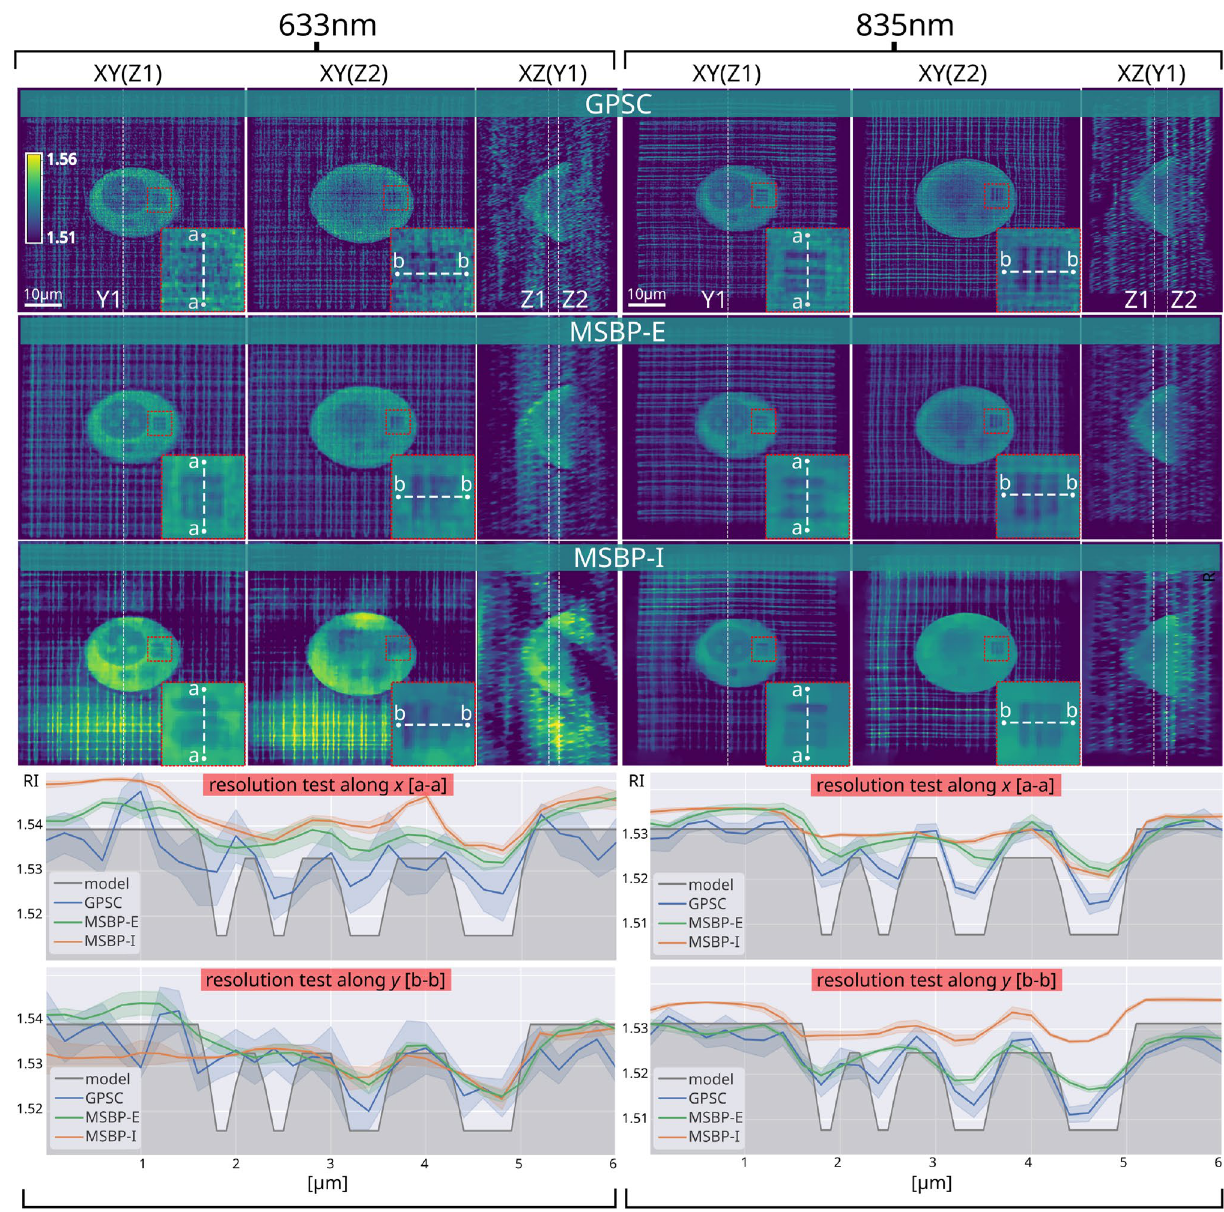
Figure 2. Comparison of tomographic reconstructions of the microphantom measured with 633 nm and 835 nm wavelength and calculated with 3 algorithms. The shaded colored regions surrounding each of the 1D plots at the bottom represent the standard